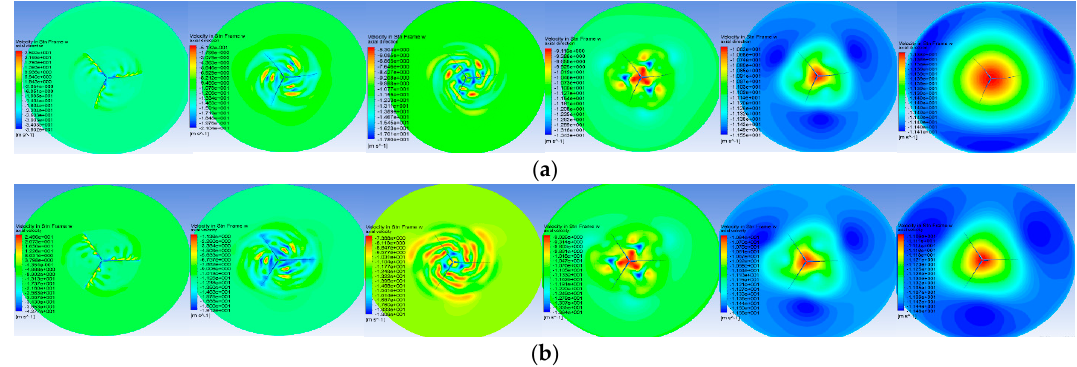
Figure 14. Axial velocity contour along the downwind direction (at 0, 10, 20, 60, 80, and 200 m behind the blade, left to right, respectively), ( a ) bi-directional; and ( b )uni-directional.